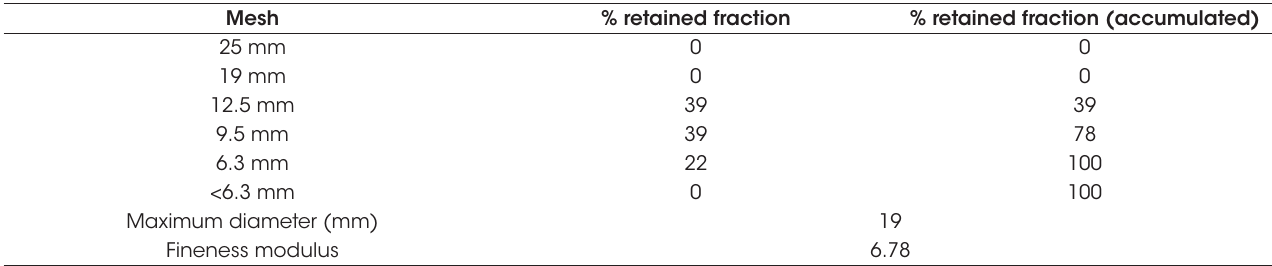
Grain size characterization of the natural coarse aggregate used